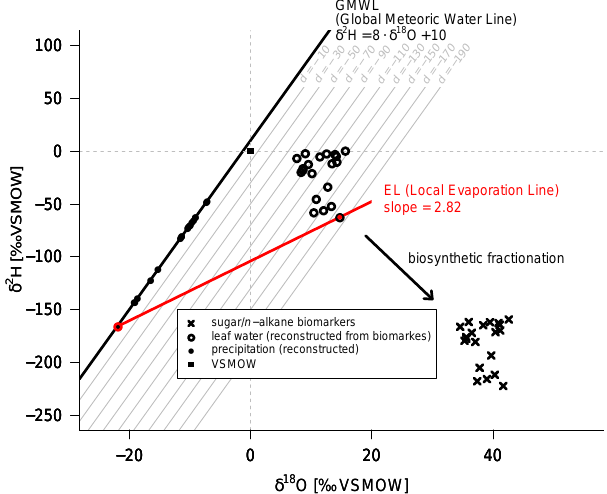
Figure 5. δ 18 O– δ 2 H diagram illustrating the conceptual model of the coupled δ 2 H n − alkane - δ 18 O sugar approach (modified after Zech M. et al., 2013). δ 2 H n − alkane (mean of n -C 29 and n -C 31 ) and δ 18 O sugar (mean of arabinose, fucose and xylose) results are used to reconstruct δ 2 H /δ 18 O leaf water by subtracting the biosynthetic fractionation factors. The deuterium excess ( d = δ 2 H – 8 · δ 18 O) of leaf water serves as proxy for RH, and δ 2 H /δ 18 O prec is calculated as the intersection of the individual evaporation lines (ELs, slope of 2.82) with the GMWL.